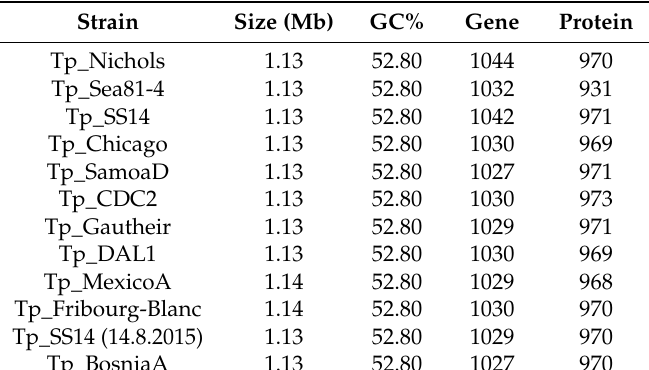
Table 1. Genomic features of all T. pallidum (Tp) strains.